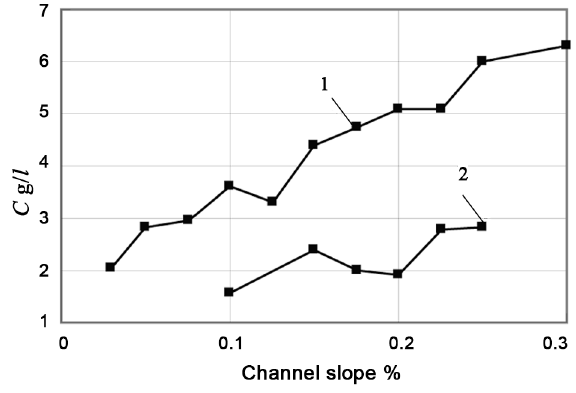
Fig. 7. Distorted by sediment clouds dependence of measured transportable suspended sediment concentration C on the chan- nel slope (Graf and Cellino). Diameter of sand particles: 1 – D 50 = 0.135 mm, 2 – D 50 = 0.23